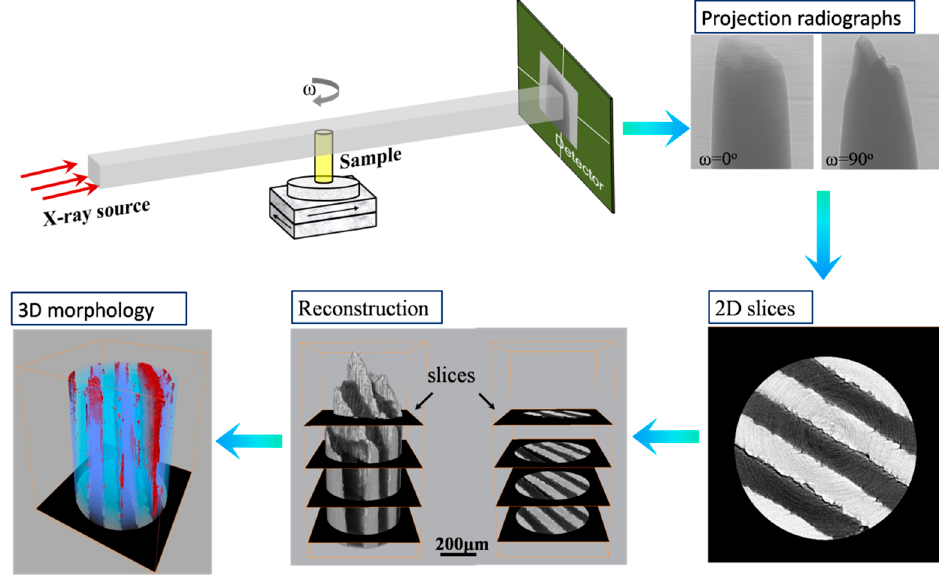
Figure 1. Schematic diagram of imaging principle of X-ray computed tomography.